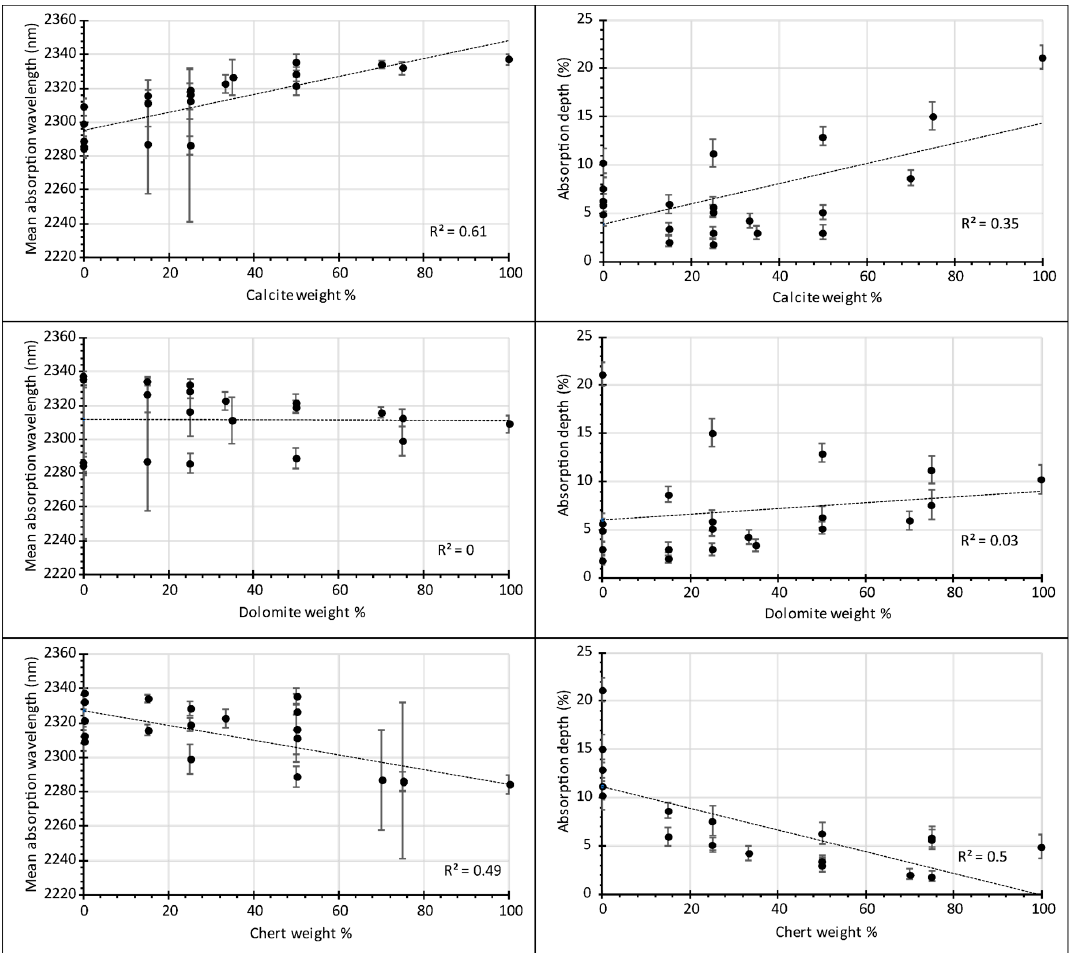
Figure 5. Minimum wavelength locations and depths of prepared mixtures measured from hyperspectral imagery, compared to mineral proportions by weight. Error bars show standard deviation of measurements.